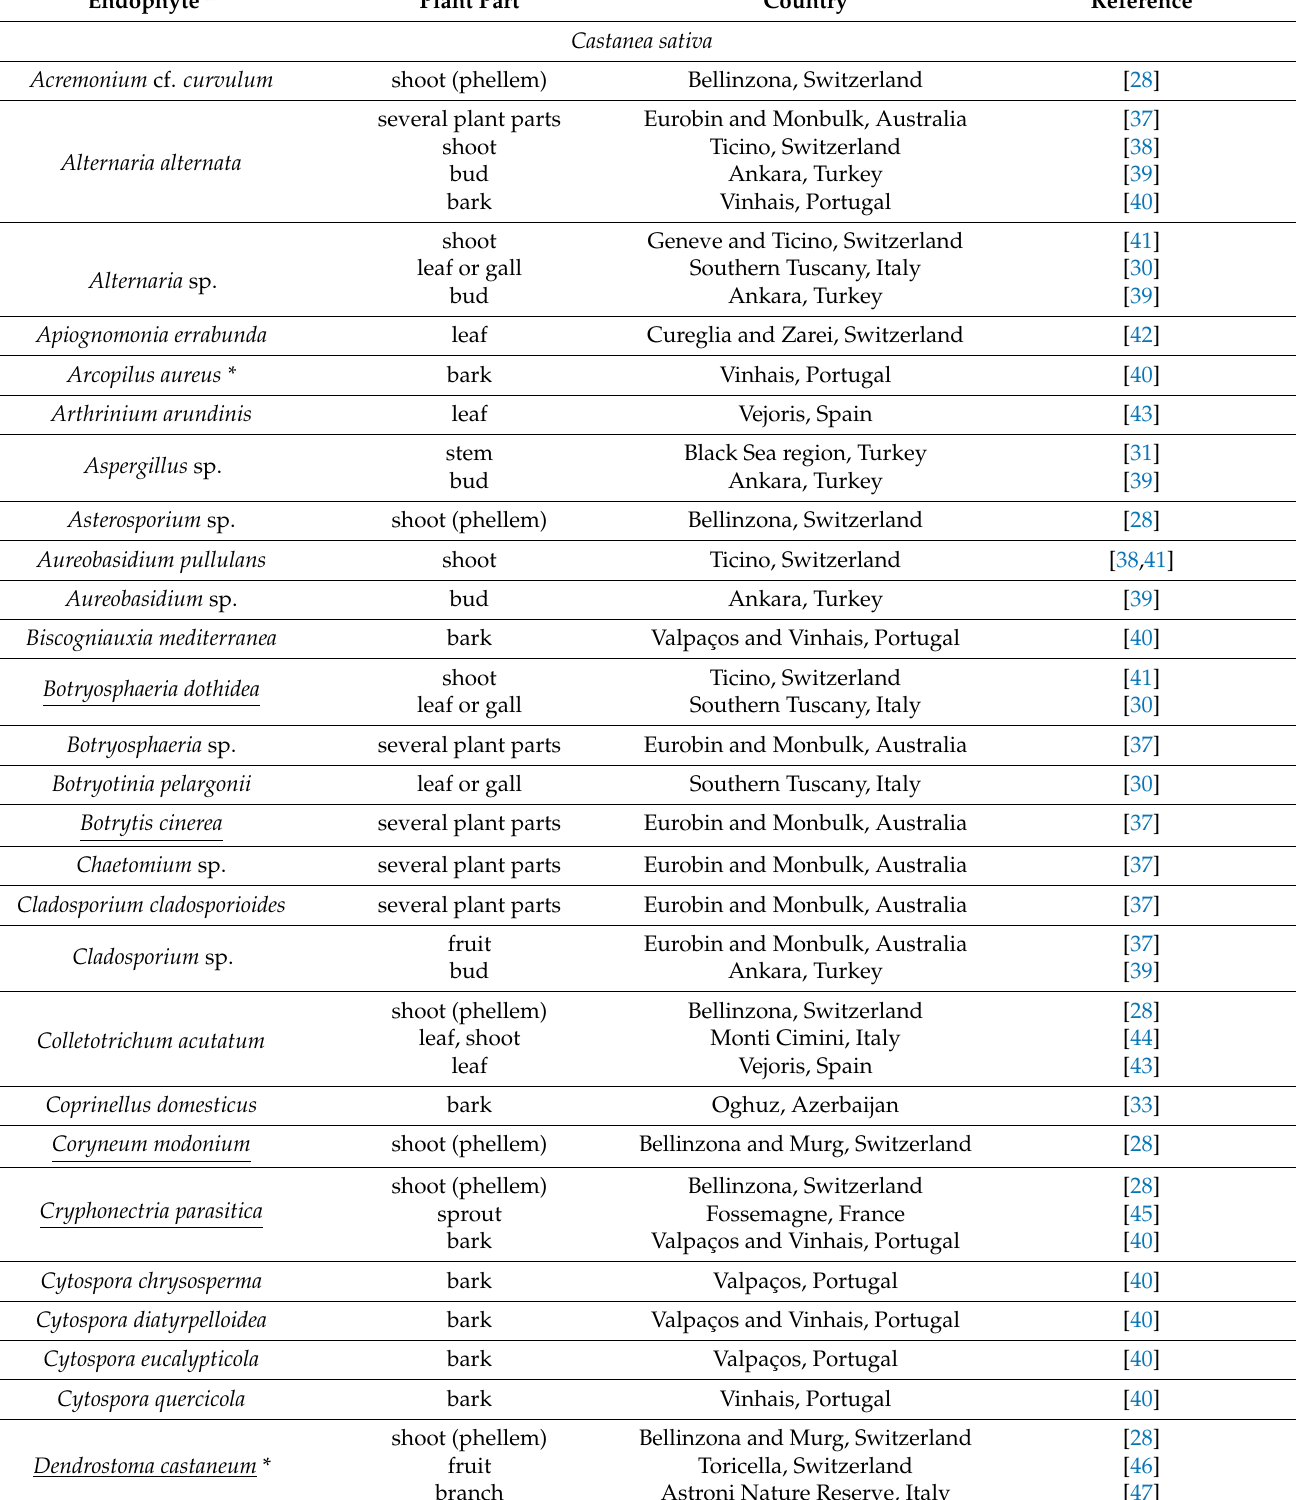
Table 1. Endophytic fungi reported from Castanea